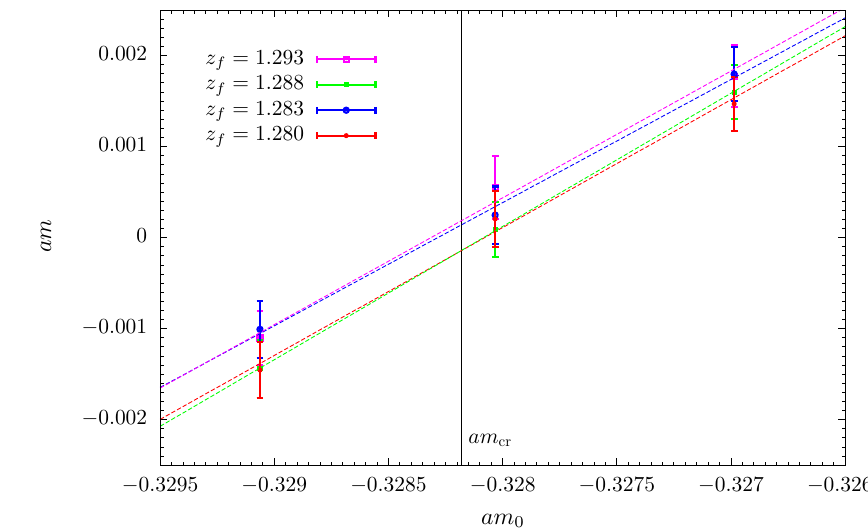
Fig. 1 Results for the PCAC mass as a function of the bare quark mass, for different values of z f . The dashed lines are linear fits to the data, while the solid vertical line indicates the location of our final estimate for am cr ( g 0 , a / L ) (s. main text). The results are for L / a = 8 and β = 5 . 3